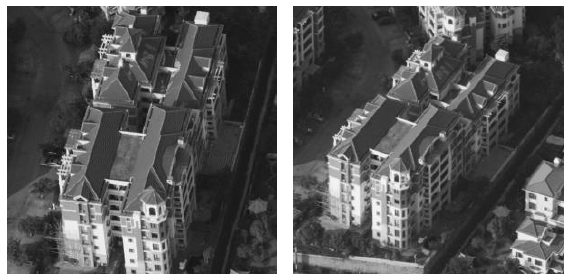
Figure 8. Dataset 3: low-altitude oblique images. Image size is 1024×1024 pixels. Image resolution is